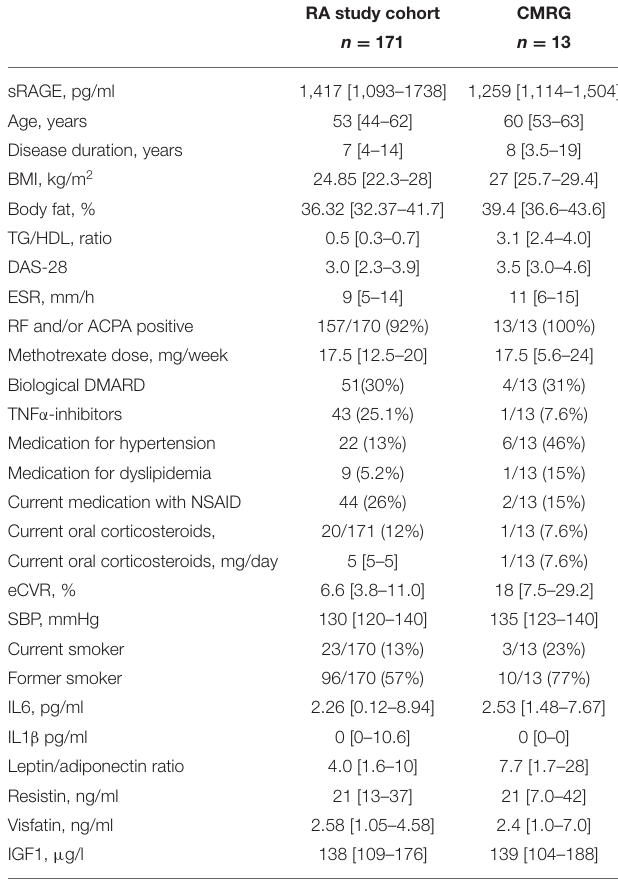
TABLE 1 | The baseline characteristic of the study cohort ( n = 171), female patients with